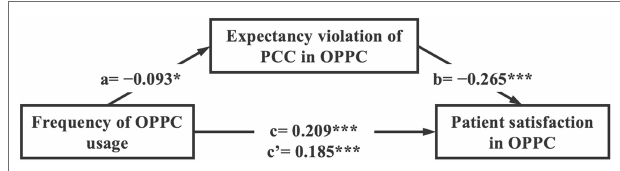
TABLE 2 | Results of the comparative analyses of OPPC and offline PPC.